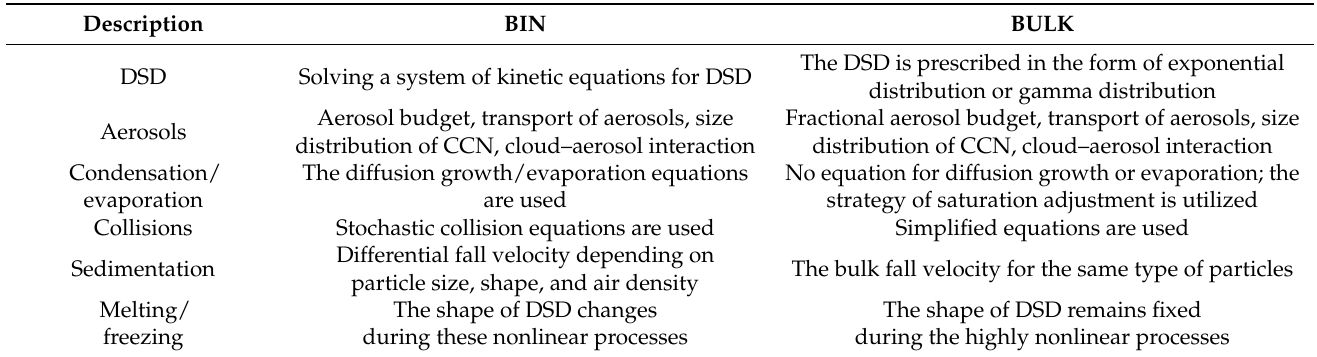
Table 2. BIN versus BULK: different description of